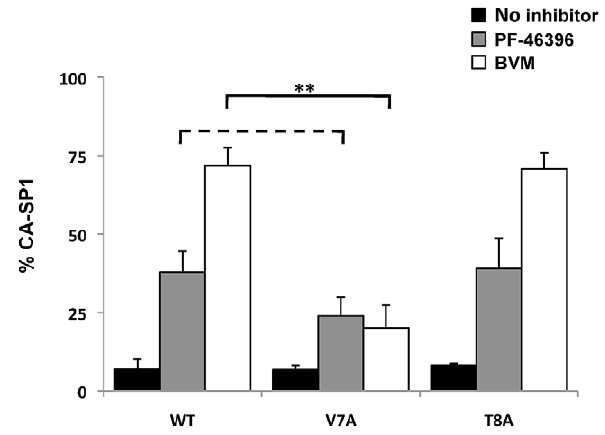
Figure 2. The SP1-V7A polymorphism has a lesser effect on sensitivity to PF-46396 than to BVM. 293T cells were transfected with WT pNL4-3 or pNL4-3 derivatives bearing SP1-V7A or SP1-T8A polymorphisms and treated with 1 m M BVM or PF-46396. CA-SP1 processing efficiency was examined in virions by radioimmunoprecip- itation analysis. P values: **, p , 0.01; dashed line, no significant difference. Error bars indicate SD; N=3.